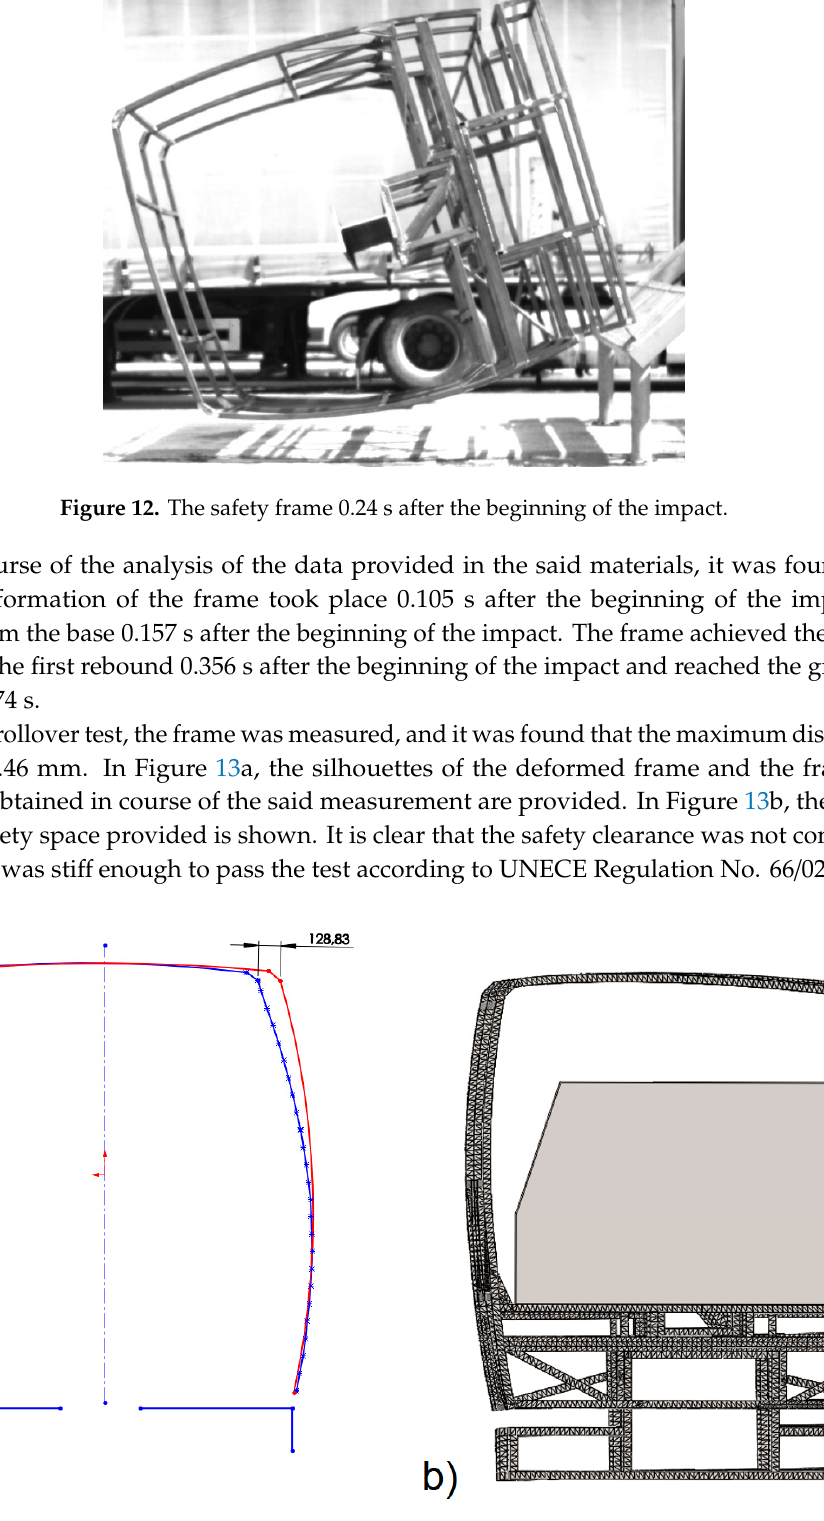
Figure 13. The contours of the safety frame: ( a ) the frame contour before and the frame contour after the deformation appeared during the rollover test (results of the measurements), ( b ) deformed frame with safety space.